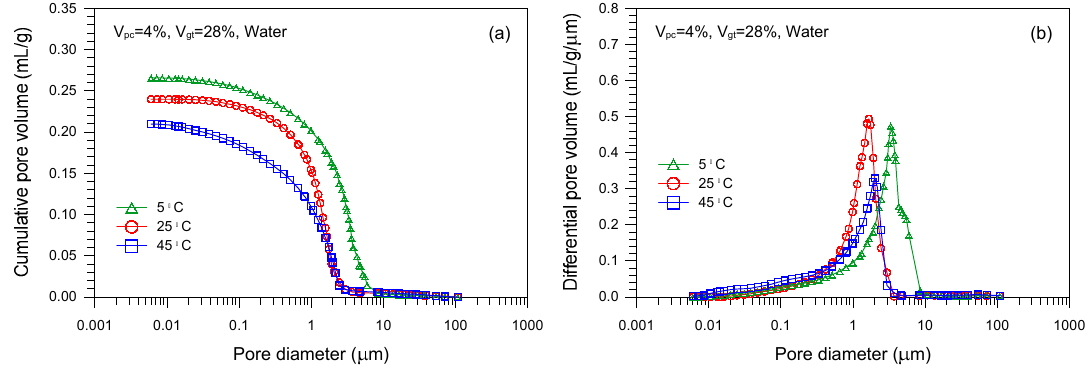
6 of 9 Figure 4. Effect of cement volume fraction on pore size distribution of cement-stabilized tailings: ( a ) cumulative intrusion curve, ( b ) differential instruction curve. Figure 5 shows the effect of curing temperature on the pore size distributions of cement- stabilized tailings. In Figure 5a, the total pore volume of samples cured at hotter temperature is lower than those of samples at colder temperatures. The obtained results can be mainly attributed to the fact that the higher curing temperature accelerates the hydration of cement. This in turn, leads to the formation of more cement hydration products which reach the dense and finer pore structure. Also, the observation may be associated with a modification of the type of hydrate formed. In cement chemistry, it is well known that the transformation of lamellar hydrates to cubic hydrate is accompanied by a change in volume [25]. Also, Wang et al. [11] analyzed cement kiln dust and fly ash pastes cured at different temperatures and found that when curing temperature increased from 24 to 38 °C, the binder strength increased significantly. They noted that the strength improvement may be related to the microstructure development of the pastes. From Figure 5b, it is noticed that the pore size of samples cured at 5 °C generally differs from that of samples at 25 and 45 °C. Especially,